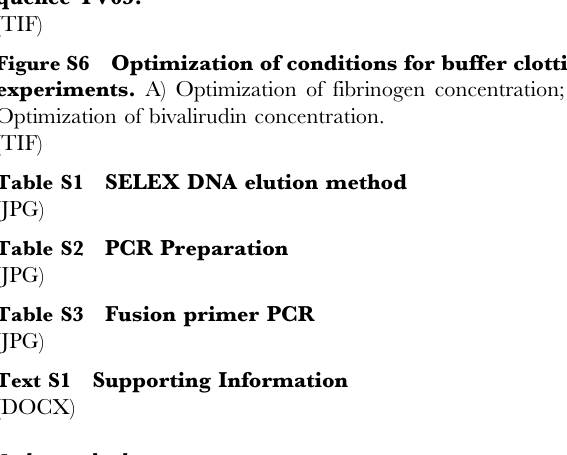
Figure S3 PCR protocol for amplification. (TIF) Figure S4 Sample alignment of JPB2 (green highlighted portion) using MAFFT. (TIF) Figure S5 Dissociation constant curve of control se- quence TV03. (TIF) Figure S6 Optimization of conditions for buffer clotting experiments. A) Optimization of fibrinogen concentration; B) Optimization of bivalirudin